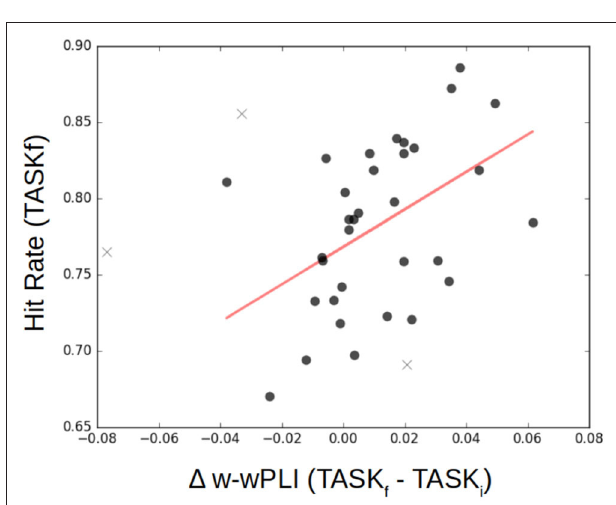
FIGURE 10 | Decrease of selfsimilarity vs. increase in functional connectivity assessed from fractal dynamics from rest to task. 1 H = H TASK function of 1 W-wPLI = W-wPLI TASK whole brain for each of the 36 participants (each marked as a dot), shows that the decrease of selfsimilarity correlates negatively ( r = − 0.33, p = 0.05) with the increase of functional connectivity assessed from fractal dynamics.